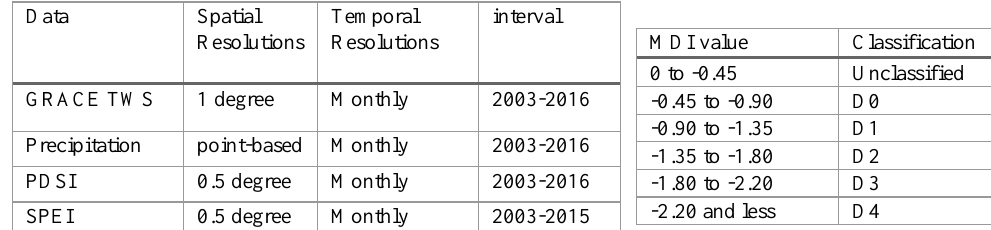
Table 1. General description of the data